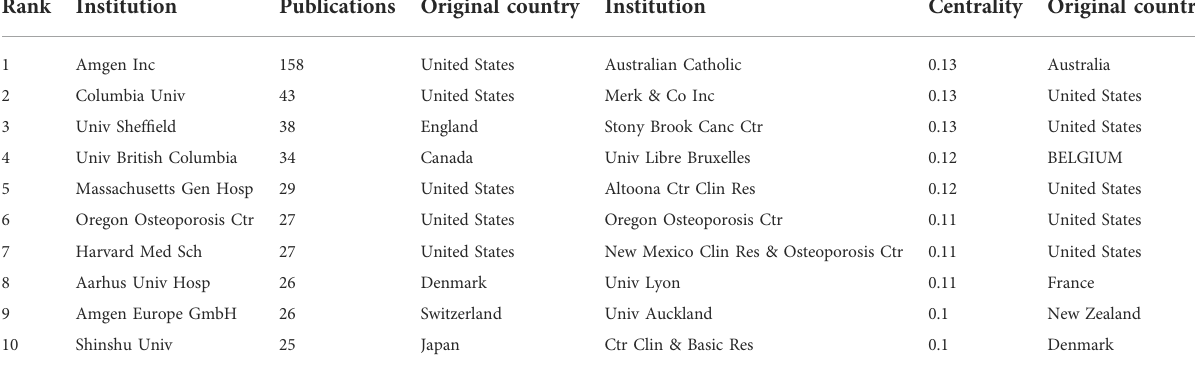
TABLE 2 Top 10 institutions in terms of publishing volume and centrality. Rank